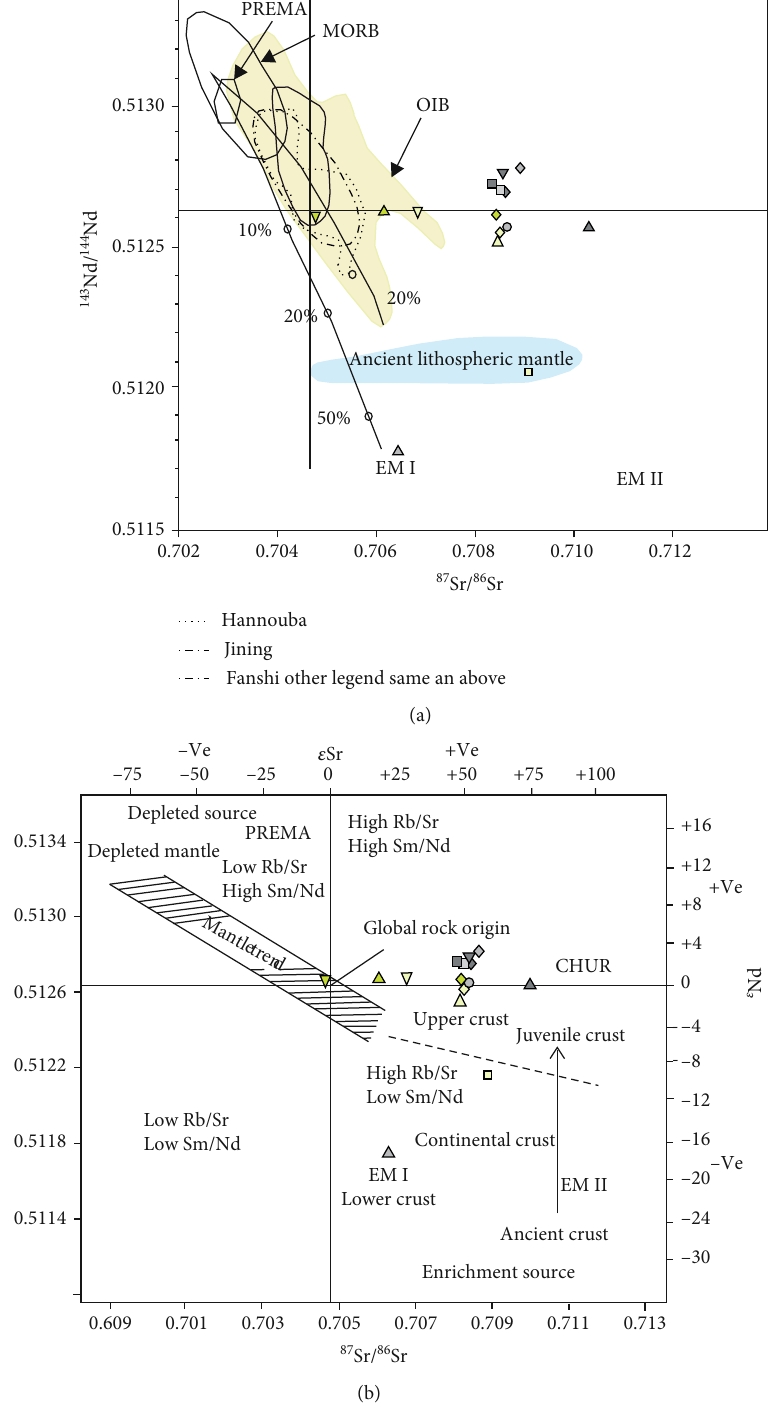
Figure 7: 87 Sr/ 86 Sr vs. 144 Nd/ 143 Nd costing point of Paleogene igneous rocks in Huimin Sag. Data sources in (a): Hannuoba basalts [58 – 60], MORB, OIB, EMI, EMII, and PREMA [61]; data source in (b): EMI, EMII, and PREMA are after Zindler and Hart [61] and Xia [62]. Symbols are as in Figure